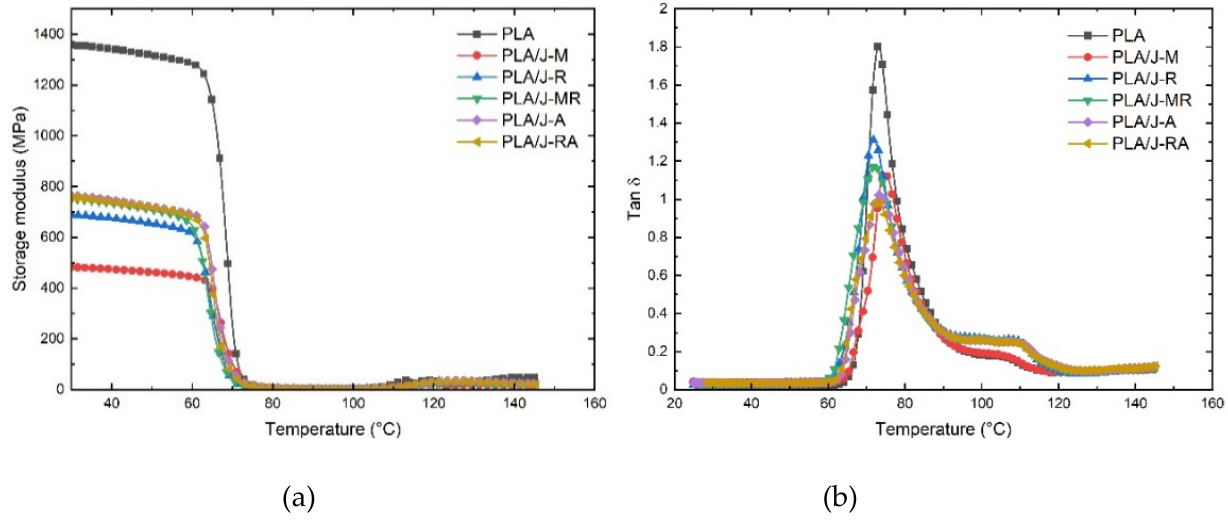
Figure 5. DMA curves corresponding to PLA and PLA composite: ( a ) storage modulus, ( b ) tang δ